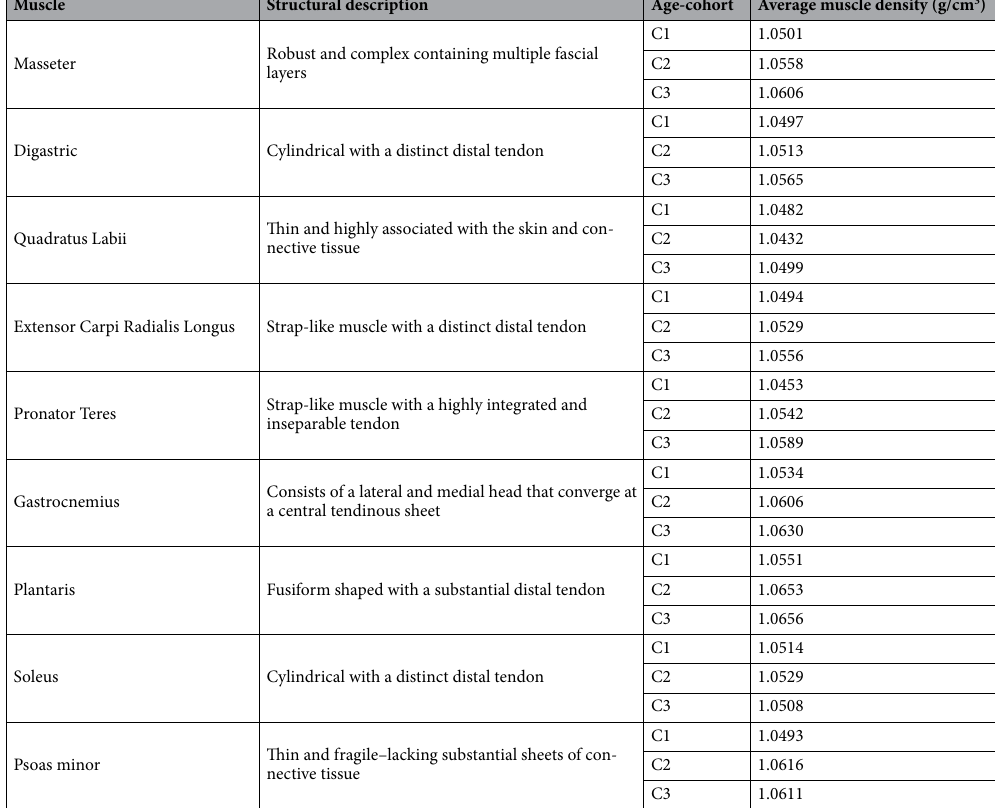
Table 6. Average muscle density by structural characteristics and